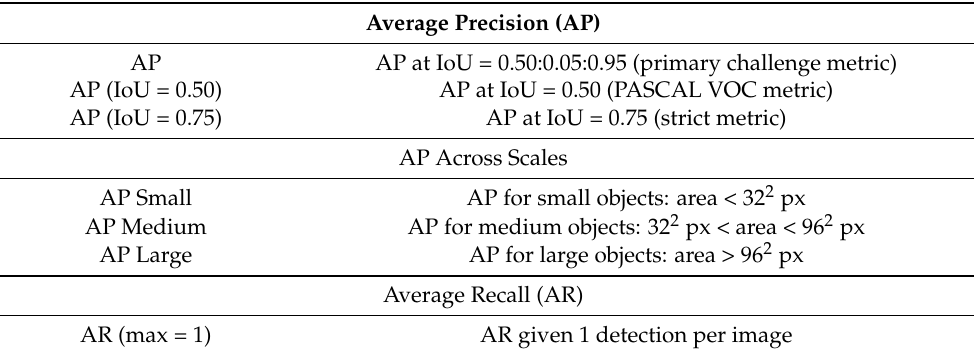
Table 6. The metrics used to evaluate the model (average precision and average recall). AP is the average precision of the intersection over union (IoU) in steps of 0.05, from 0.5 to 0.95. AP (IoU = 0.50) and AP (IoU = 0.75) correspond to APs with IoUs of 0.50 and 0.75, respectively. AR describes the doubled area under the recall–IoU